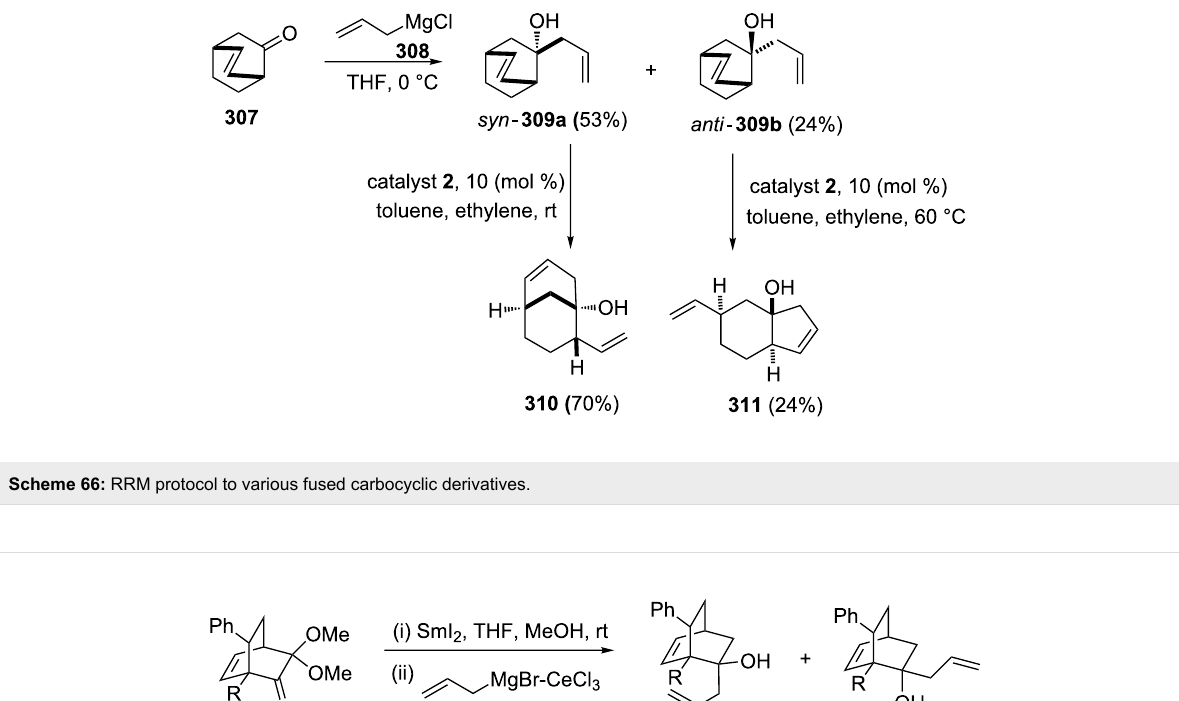
Scheme 66: RRM protocol to various fused carbocyclic derivatives.